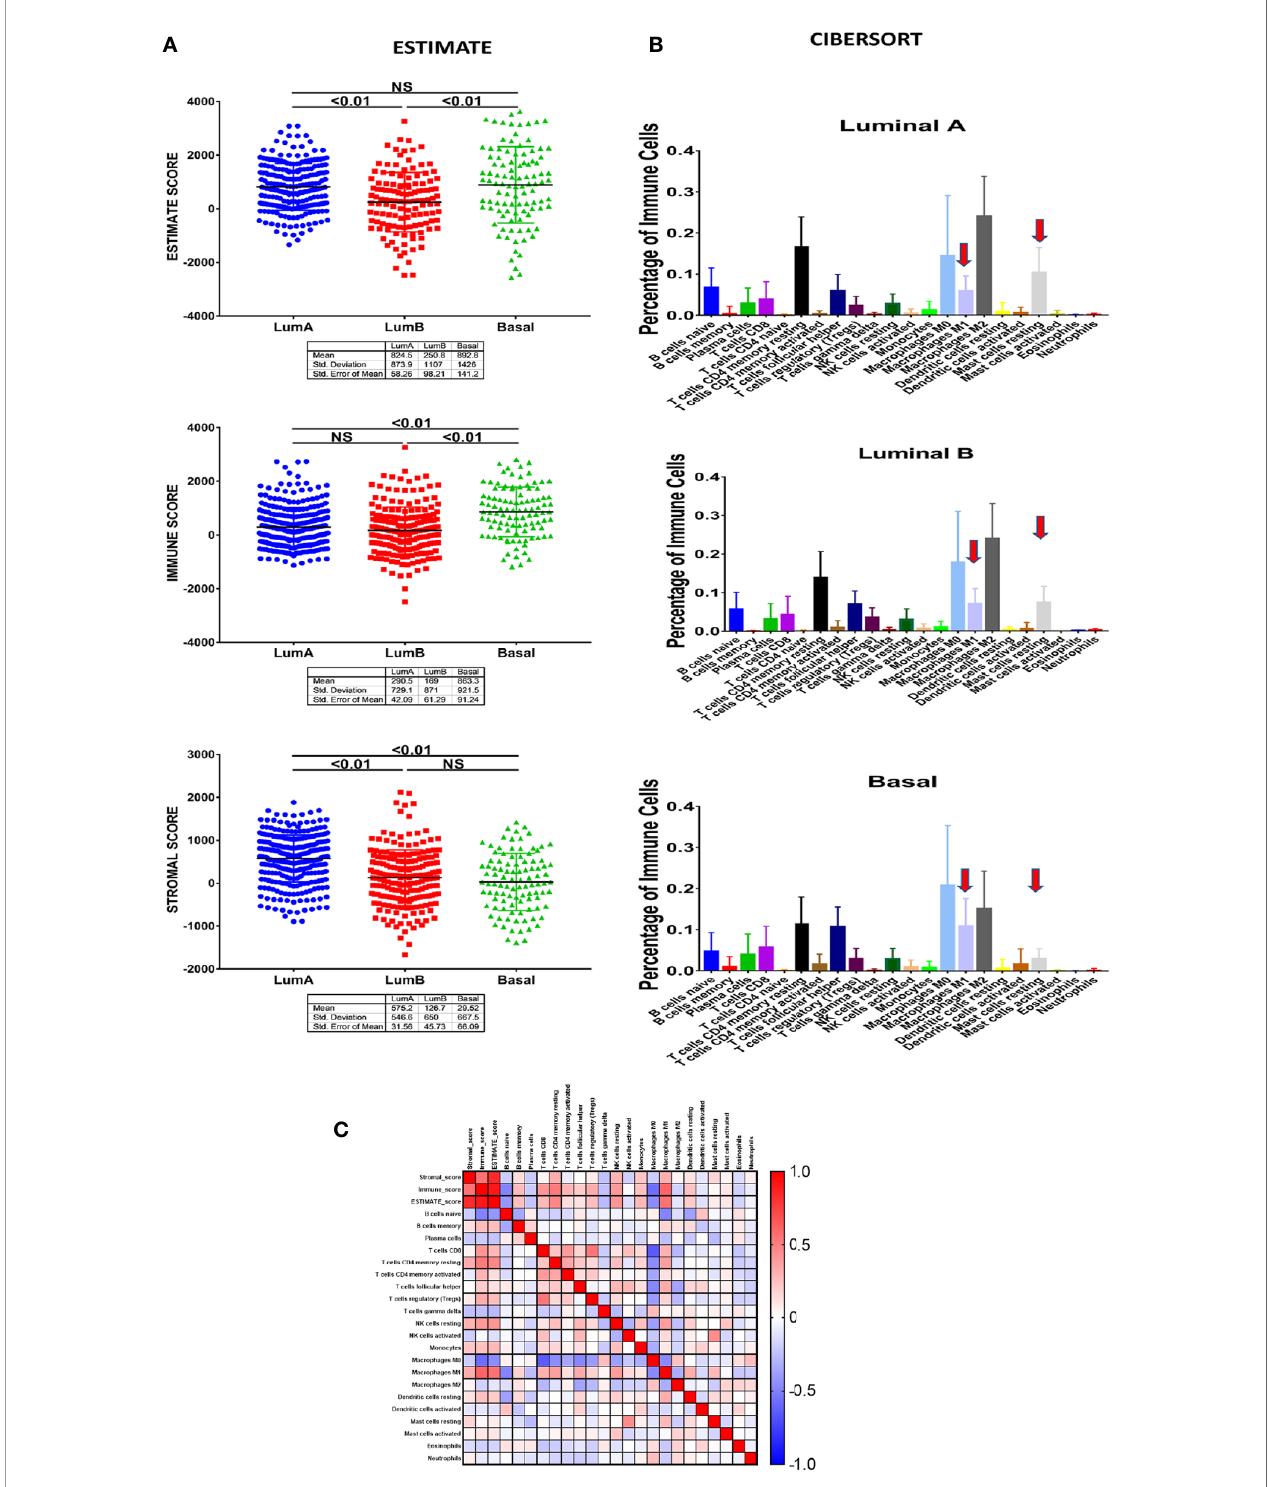
FIGURE 6 | The cellular and stromal pro fi le of clusters representative of luminal A, B, and basal-like breast cancer subtypes. (A) Estimation of Stromal and Immune cells pro fi le in clusters representative of luminal A, B, and basal-like breast cancer subtypes using Expression data (ESTIMATE) tool. (B) The percentage of immune cell in fi ltration in basal versus luminal A and B breast cancer cells as predicted by CIBERSORT analytical tool. (C) Non-parametric Pearson correlation matrix for immune cells showing different correlation of M1 and M2 to other in fi ltrating immune